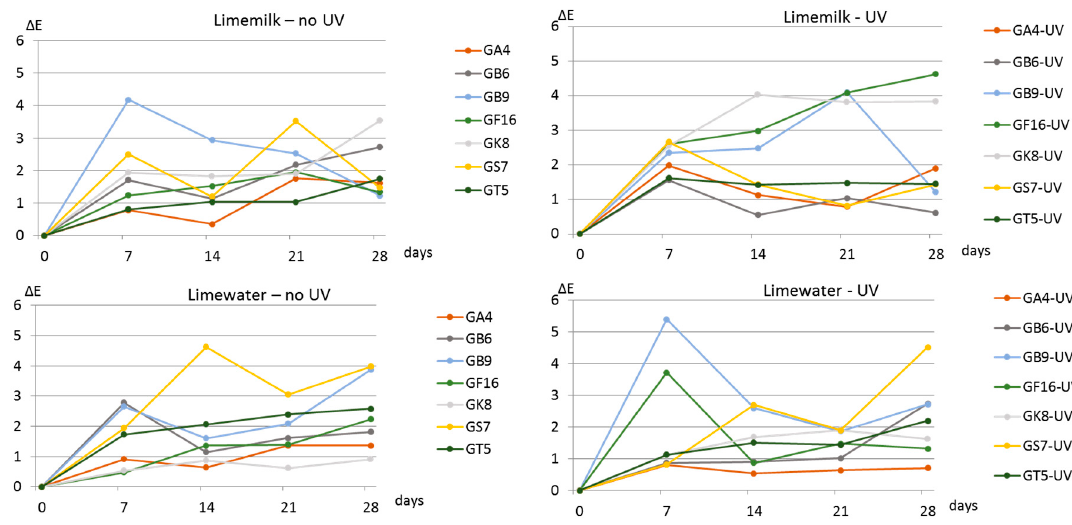
ff erence diagrams for the period of 28 days. Figure 16. Colour difference diagrams for the period of 28 days. Figure 16. Colour di